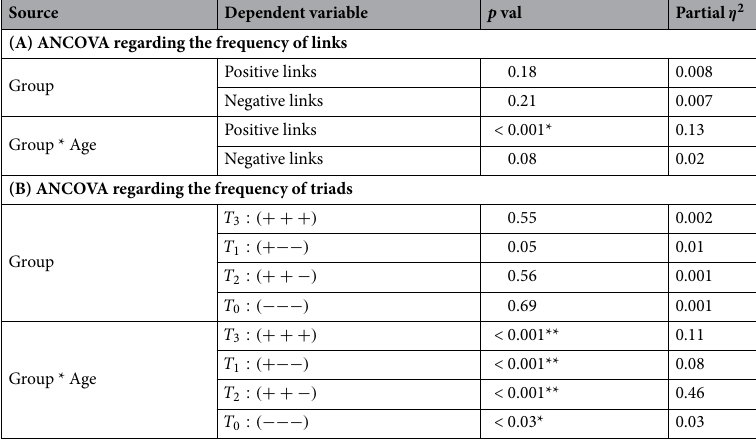
Table 2. Analysis of covariance for the frequency of links versus triads. (A) The effect of group is not significant on the mean frequency of links. The effect of interaction between group and age is only significant for the positive links, yet not practically significant. (B) For triads regarding the effect of interaction between group and age, not only all the differences are statistically significant but the effect size (partial η interestingly considerable for T 2 . ** p < 0.01 , * < 0.05 (Bonferroni corrected).